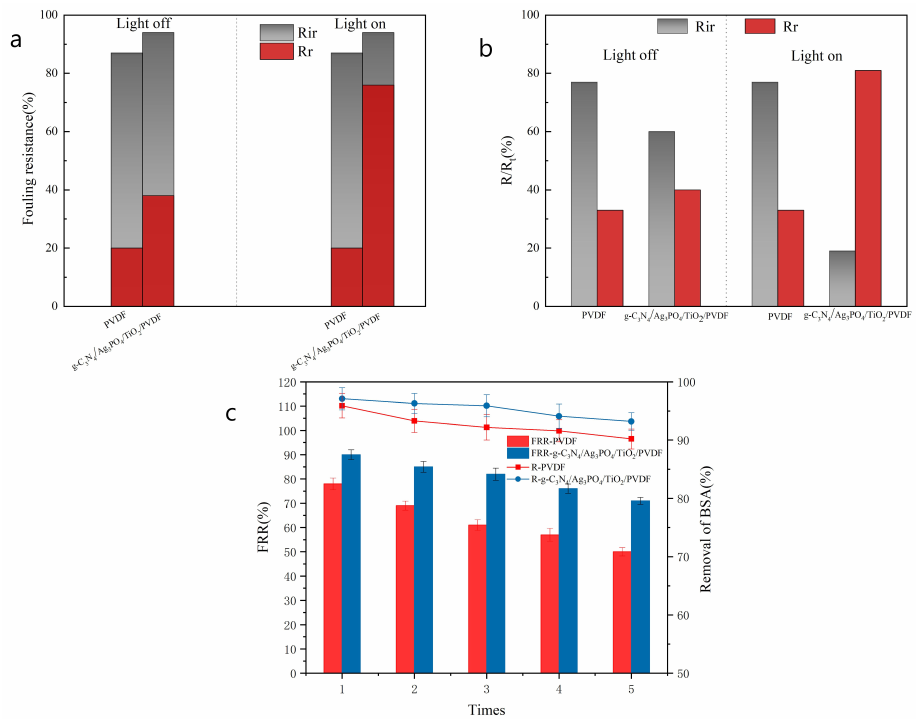
Figure 8. ( a ) The antifouling property and ( b ) the ratio of irreversible fouling to reversible fouling of the membranes, and ( c ) the flux recovery ratio and rejection of BSA (initial BSA concentration of 300 mg/L, pH = 6.9).